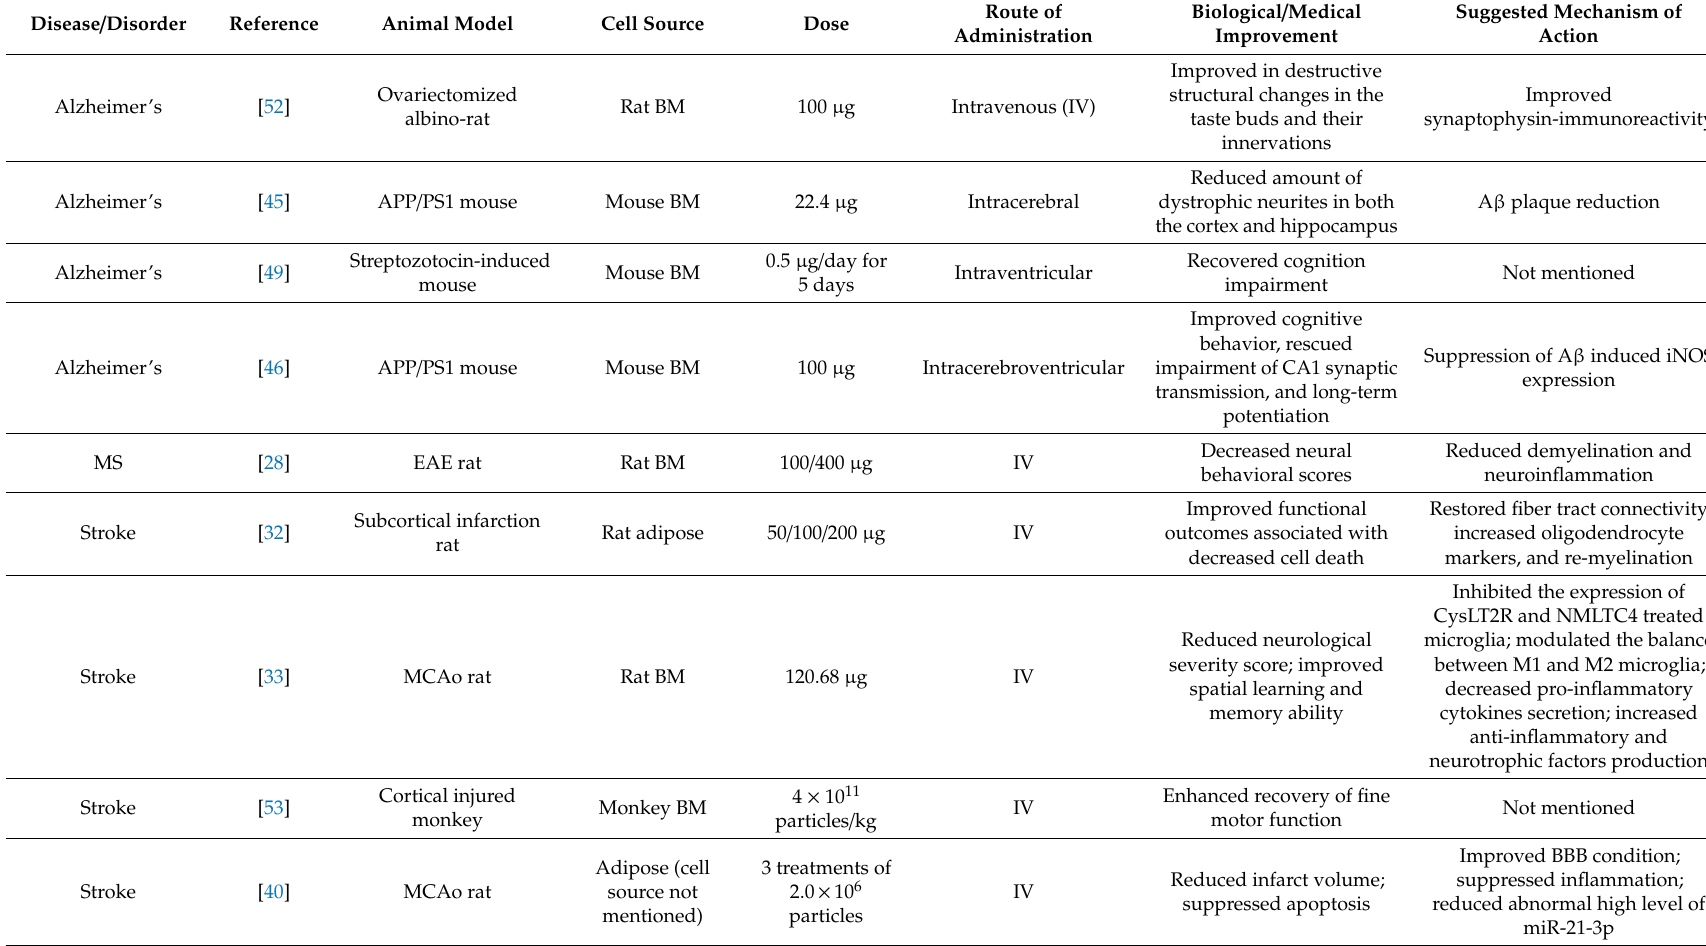
Table 2. Naïve non-human MSC-derived exosomes in animal models of